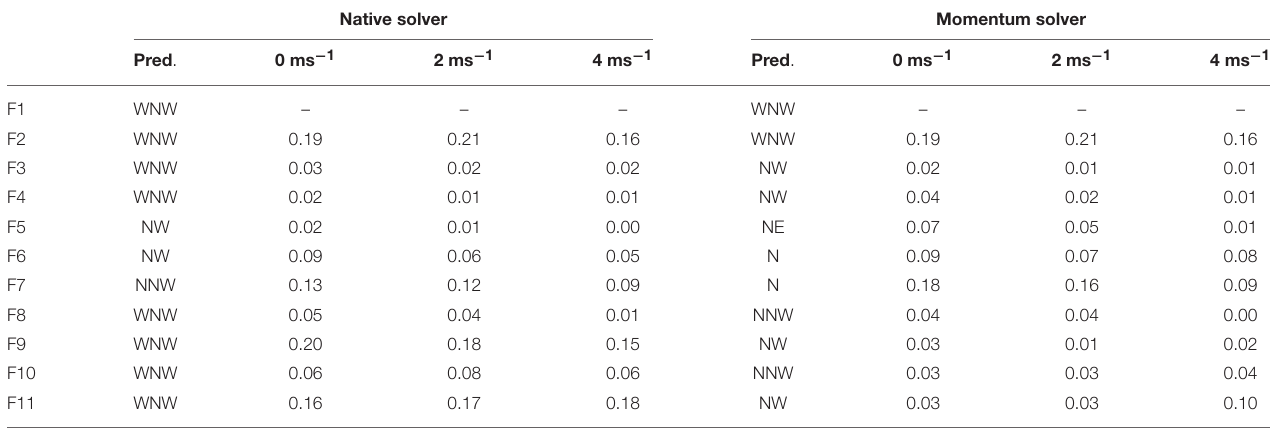
TABLE 4 | Proportion of agreement between predicted wind direction (as compass point) and observed wind direction distribution at each site across Flea Creek Valley, conditional on observing a wind direction of WNW at F1. Native solver